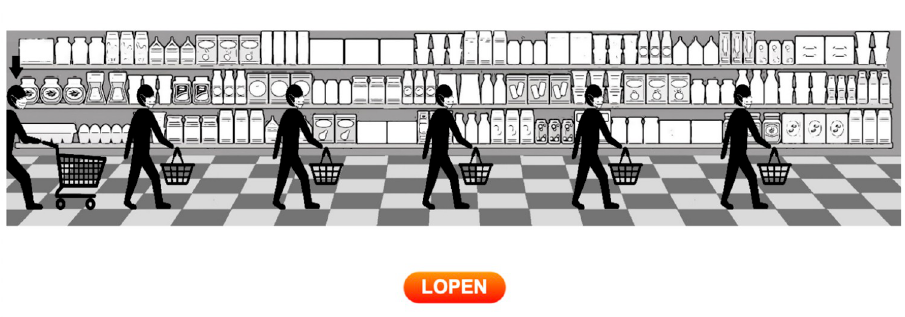
Fig 1. Screenshot of the behavioral task in the supermarket context. The word “lopen” on the button is Dutch for “walk”.